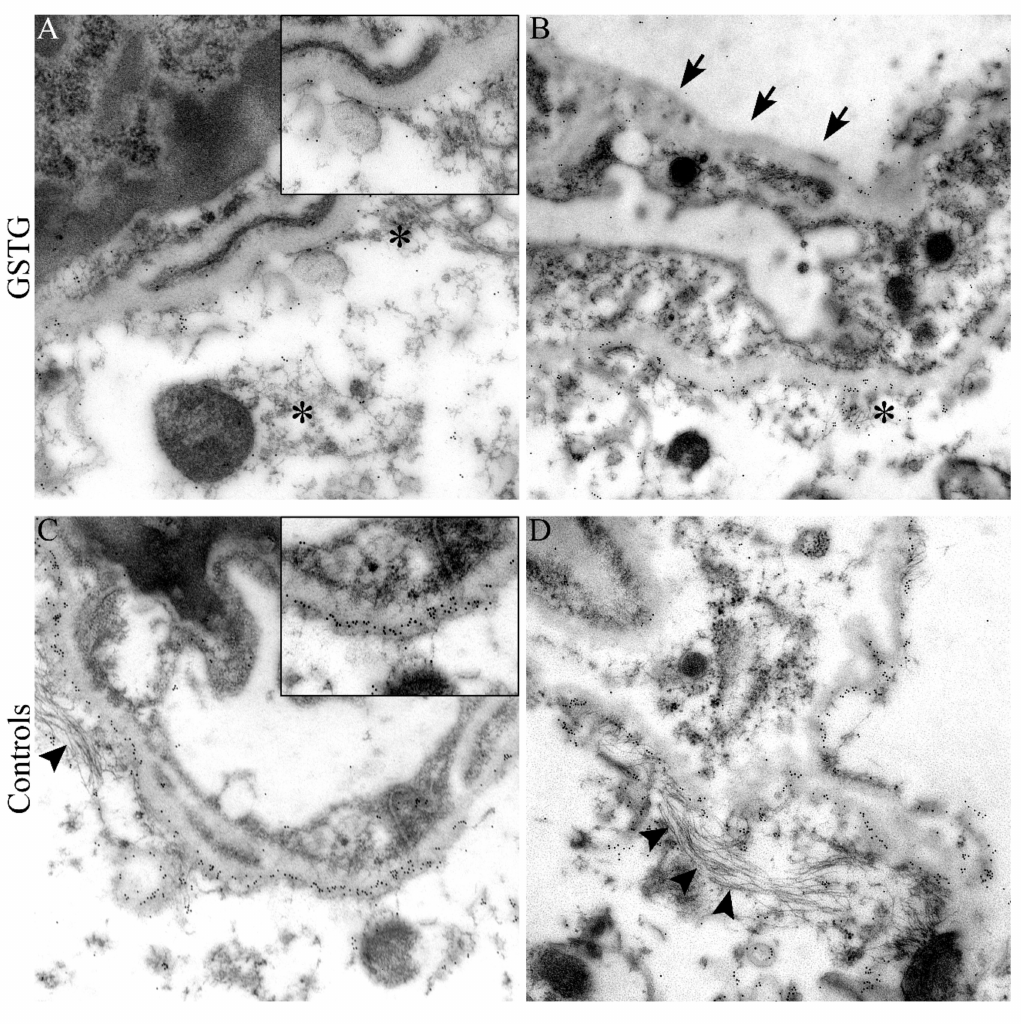
Figure 5. Immunoelectron microscopy targeting aquaporin 4 (AQP4). Immunoelectron microscopy of the thoracic spinal cord segment was performed for the localization of AQP4 within perivascular astrocytes. A reduced amount and an irregular distribution of AQP4 protein along the cytoplasmic membrane of perivascular astrocyte end-feet (arrows in B ) in TMEV infected, ganciclovir treated, Gfap -transgenic (GSTG, A , B ) mice compared to control mice ( C , D ) at 77 days post infection was detected. The distribution of AQP4 along the cytoplasmic membrane is shown in higher magnification (inserts in A , C ). The reduced expression of AQP4 in GSTG animals was associated with a shortening and disorganization of intermediate filaments (asterisks in A , B ) in comparison to control animals (arrowheads in C , D ). Magnifications are 40,000 × in A , 25,000 × in B and 31,500 in C , D